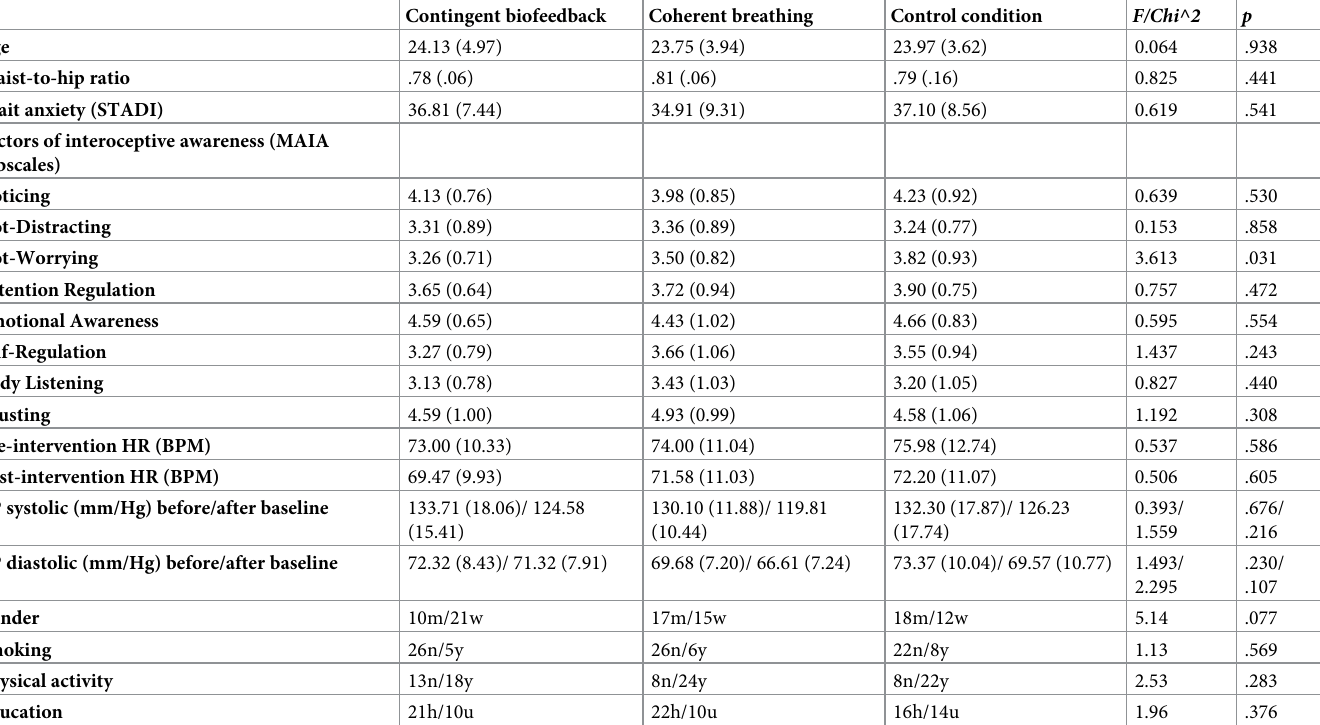
Table 1. Descriptive data of the three experimental